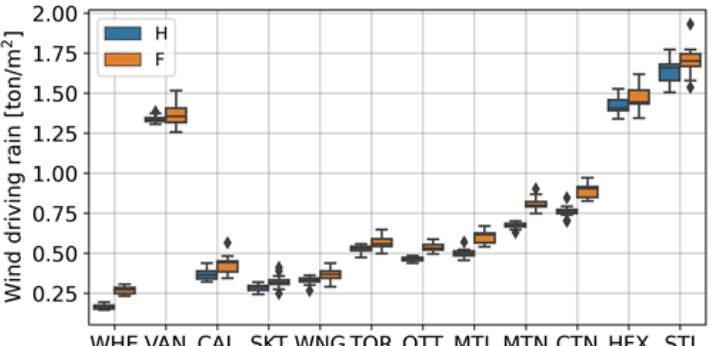
Figure 4. Boxplots of the run means of the yearly sums of wind-driven rain for historical (H) and future (F) time-periods in the 12 cities studied.